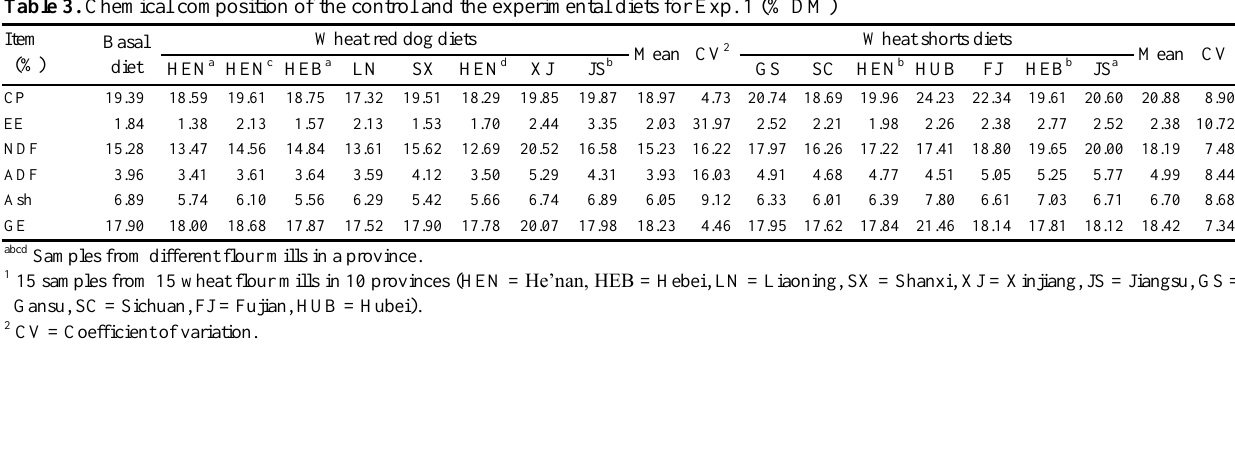
Table 3. Chemical composition of the control and the experimental diets for Exp. 1 (% DM) Item Basal (%) diet